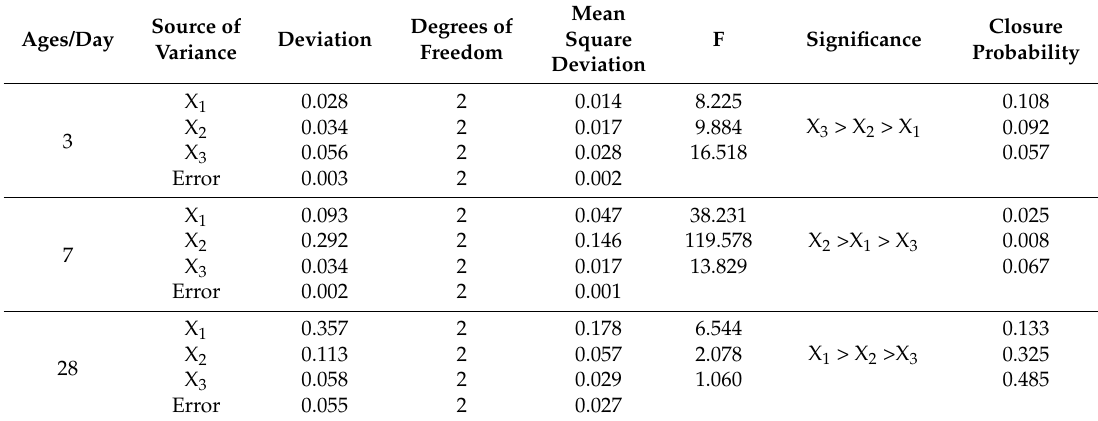
Table 5. Variance analysis results.